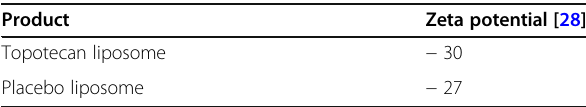
Table 14 % Leakage of topotecan from liposome in 50% plasma at 37